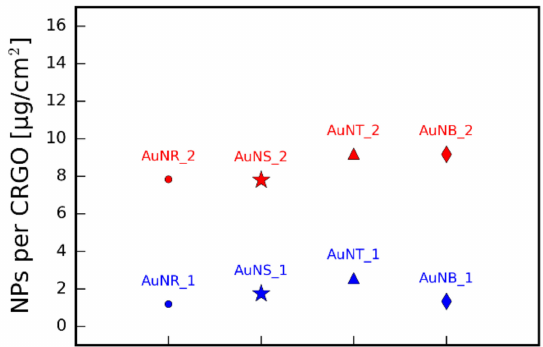
Figure 8. The estimated amount of gold per graphene area for G / NPs composites based on anisotropic nanoparticles.